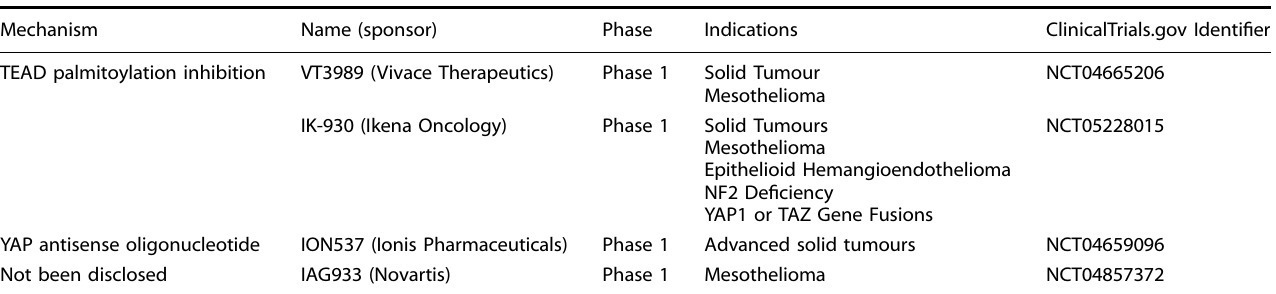
Table 2. The drugs targeting Hippo pathway in clinical trials